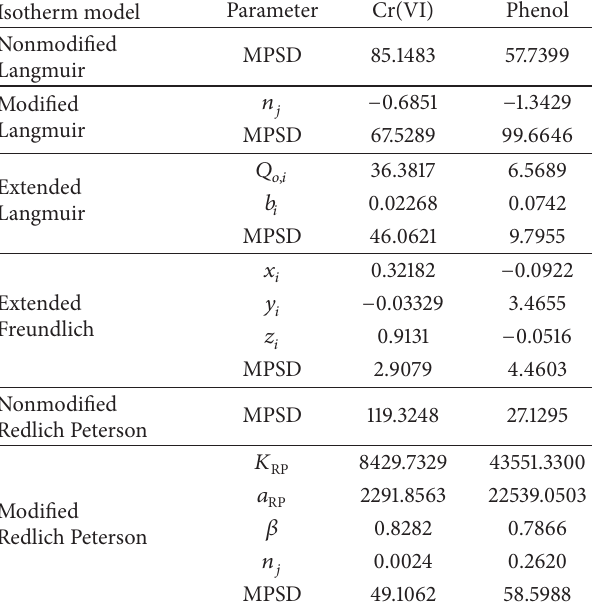
Table 2: Parameters of multicomponent isotherms for adsorption of phenol and